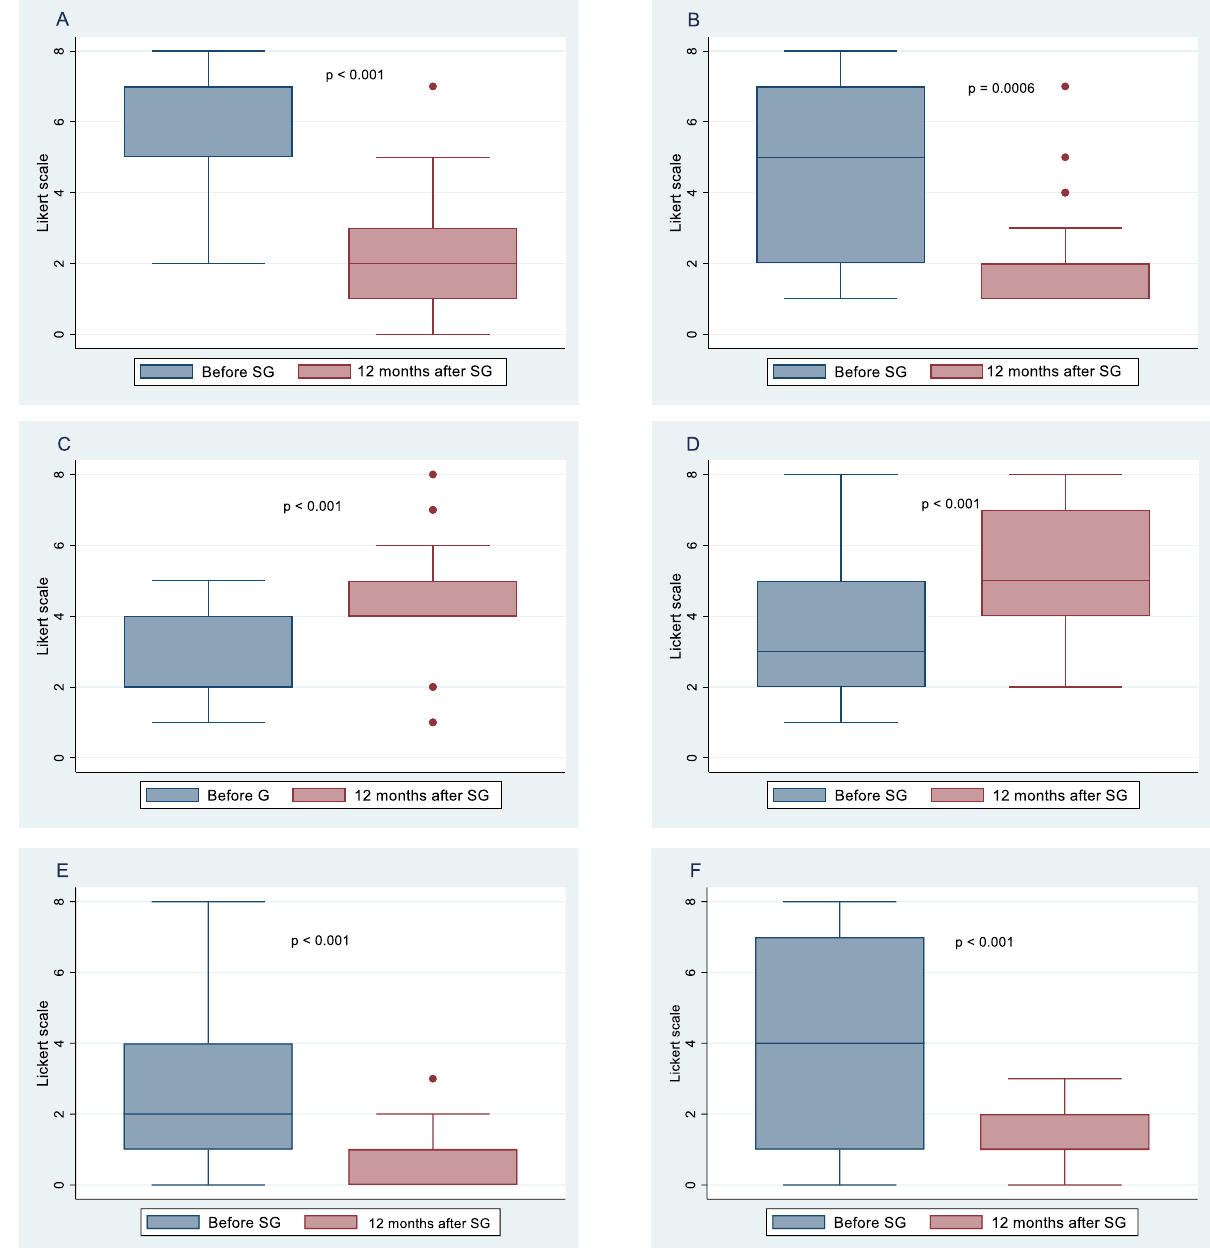
Figure 1. Food intake frequency before sleeve gastrectomy (SG) and after 10 months follow-up. Change in the frequency of meat and fish consumption in females ( A ), and males ( B ); change in the frequency of bread and crackers consumption in females ( C ), and males ( D ); change in the frequency of dairy products and fats consumption in females ( E ), and males ( F ).